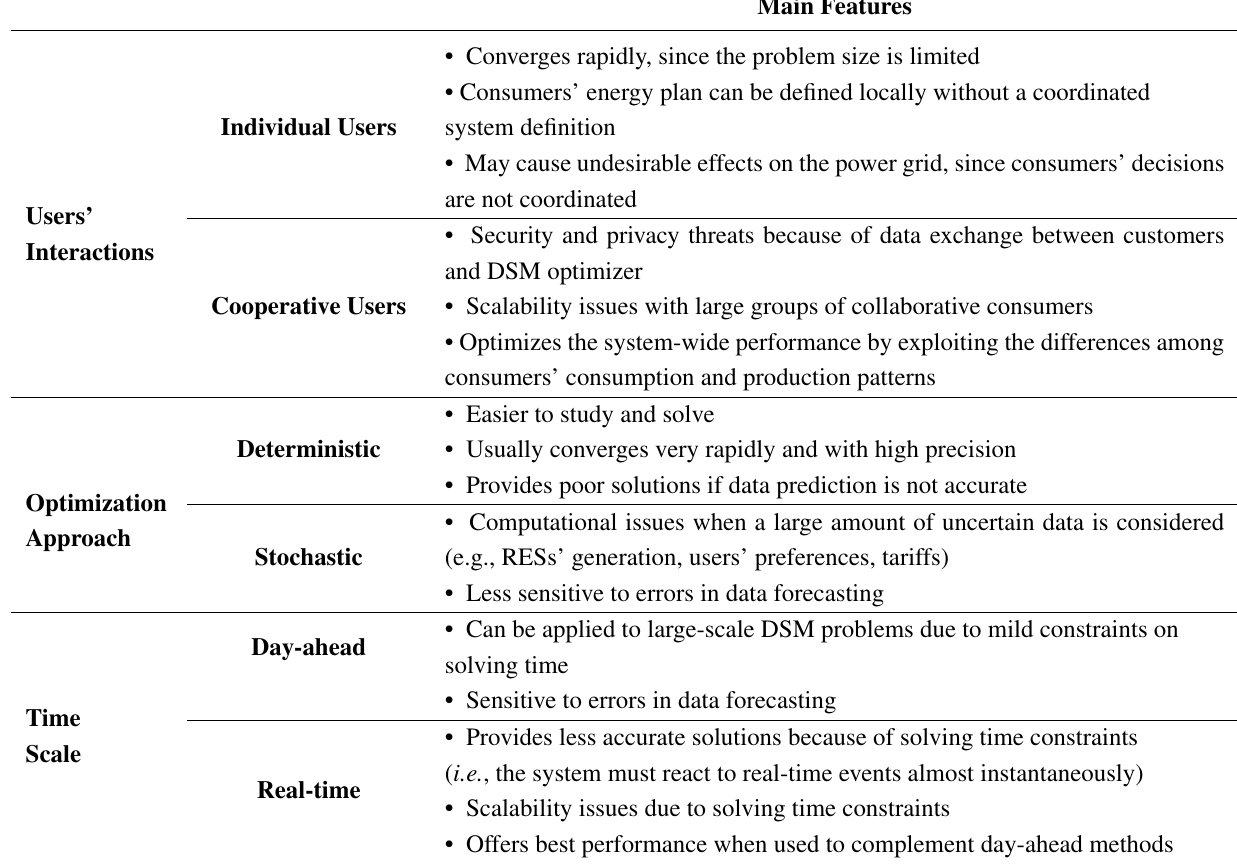
Table 3. Summary of the main features of demand-side management methods based on optimization